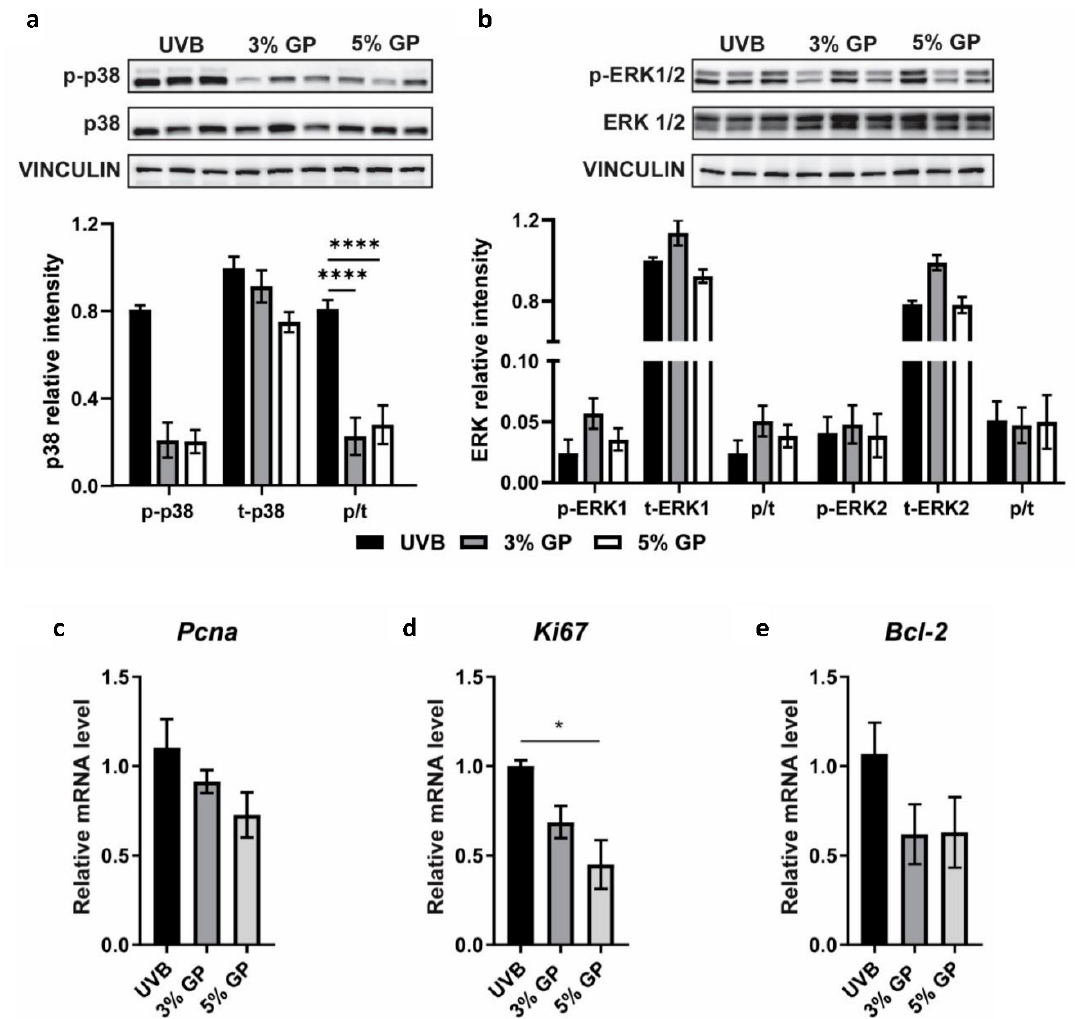
Figure 6. Dietary GP consumption reduces phosphorylation of p38 and reduces proliferation and pro-survival markers. ( a , b ) Immunoblot analysis of MAPK proteins ( a ) p38 and ( b ) ERK1/2. Vinculin (VIN) was used as a loading control. Statistical analysis was performed on the p/t ratio, which indicates the ratio of phosphorylated/total protein. ( c – e ) RT-qPCR analysis of proliferative markers ( c ) Pcna and ( d ) Ki67, and ( e ) pro-survival marker Bcl-2. Data are represented as the mean ± SEM. A one-way ANOVA with Tukey’s multiple comparison test was performed (* p < 0.05, **** p < 0.0001). (For Western Blot raw data, please refer to the Supplementary Materials Figure